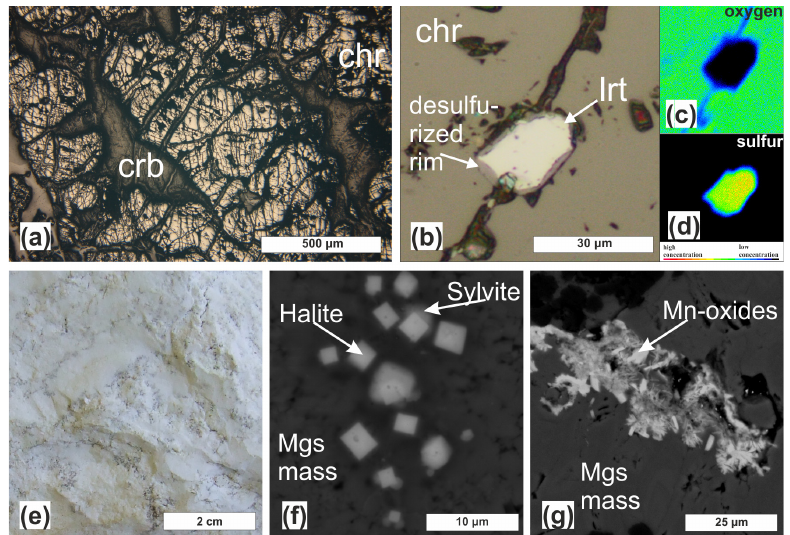
Figure 5. Photomicrographs of: ( a ) highly brecciated chromitite consisting of chromite and car- bonates; ( b ) desulfurized laurite grain entrapped in chromite; chemical mapping of the desulfurized laurite grain ( c ) oxygen concentrations; ( d ) sulfur concentrations, note that sulfur is absent from the desulfurized laurite rim; ( e ) macroscopic photo of cryptocrystalline magnesite; ( f ) back-scattered electron image of halite and sylvite grains hosted within magnesite; ( g ) back-scattered electron image of Mn-oxides hosted within magnesite. Abbreviations: lrt = laurite; Mgs = magnesite; crb = carbonate minerals; chr = chromite.